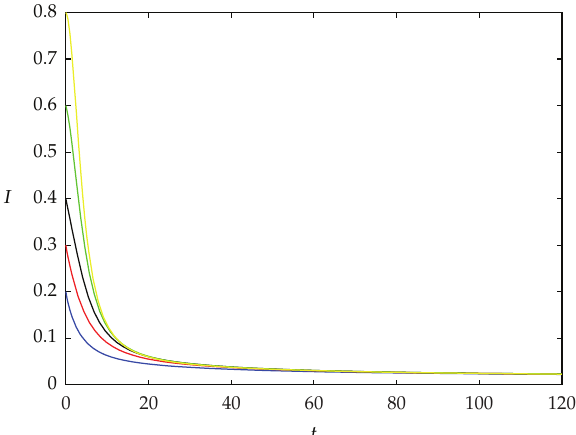
Figure 5: Time series of I (cid:3) t (cid:4) with di ff erent initial values and parameters ρ (cid:7) 0 . 3 , μ (cid:7) 0 . 2 , β (cid:7) 1 . 5 , α (cid:7) 1 , r (cid:7) 0 . 5 , d (cid:7) 0 . 2 , ω (cid:7) 0 . 1 , and τ (cid:7) 0 .